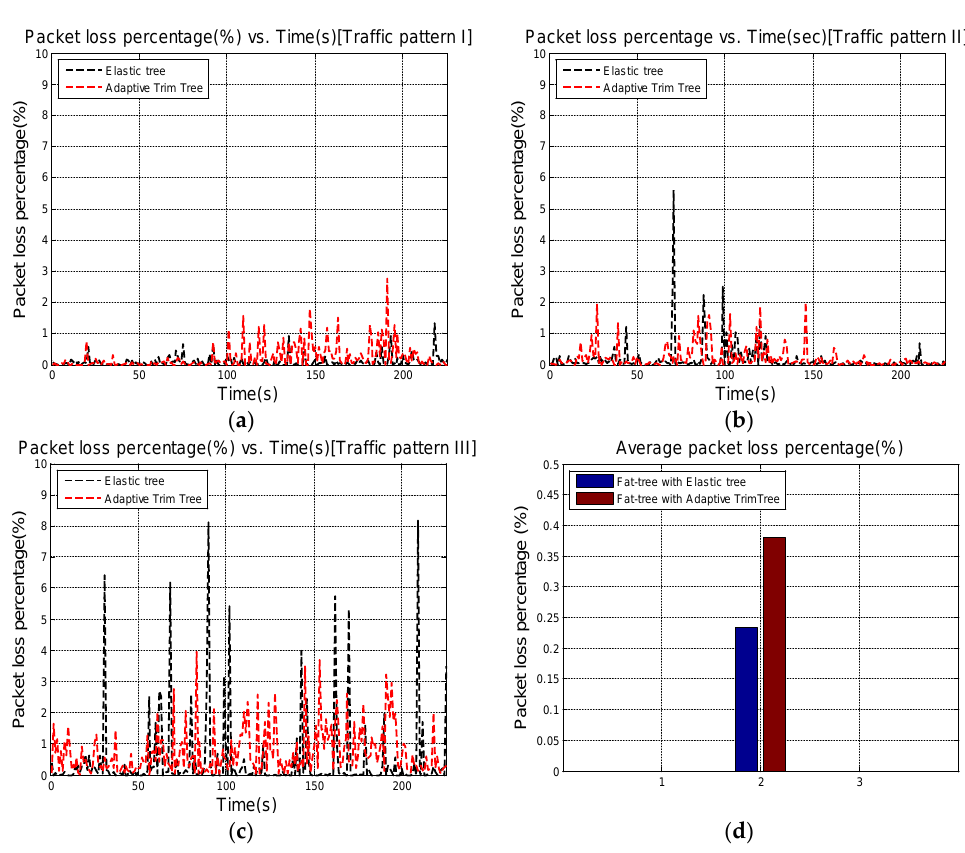
Figure 8. ( a ) Packet loss percentage Adaptive TrimTree vs. ElasticTree for traffic pattern I; ( b ) Packet loss percentage Adaptive TrimTree vs. ElasticTree for traffic pattern II; ( c ) Packet loss percentage Adaptive TrimTree vs. ElasticTree for traffic pattern III; ( d ) Average Packet loss percentage Adaptive TrimTree vs. ElasticTree.